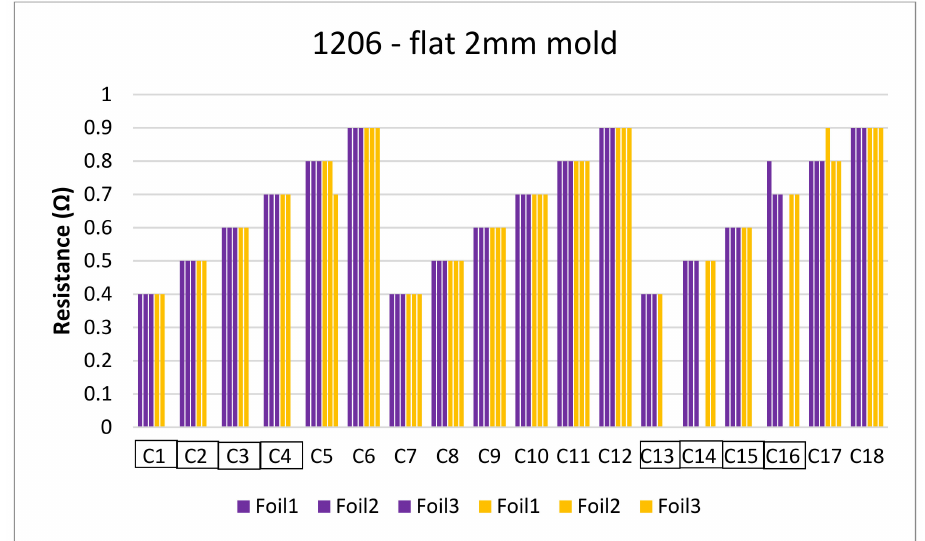
Figure 45. Resistance measurements for flat mold-2 mm for 1206 resistors.